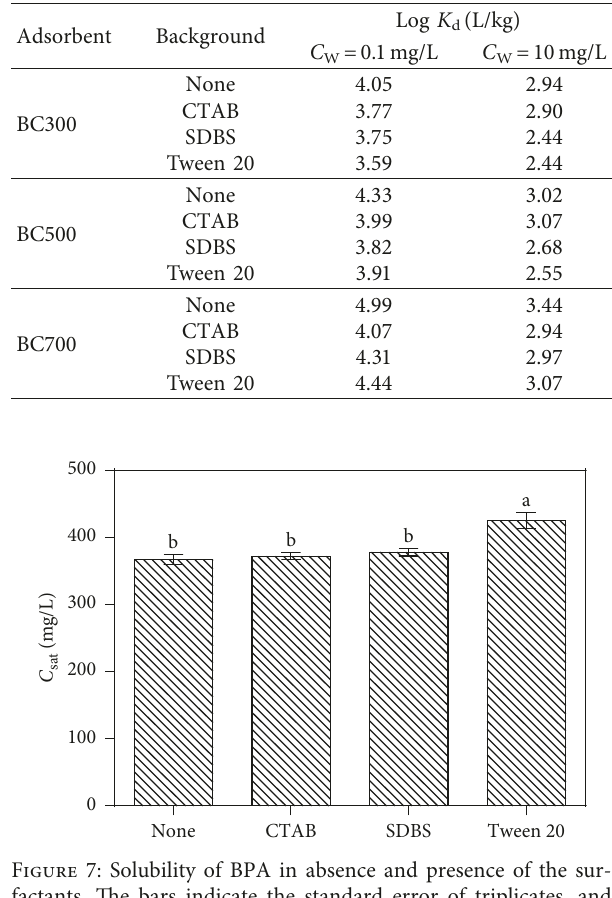
Table 5: The adsorption coefficients (log ( K d )) calculated based on Freundlich model in absence and presence of the surfactants at different equilibrium concentrations of